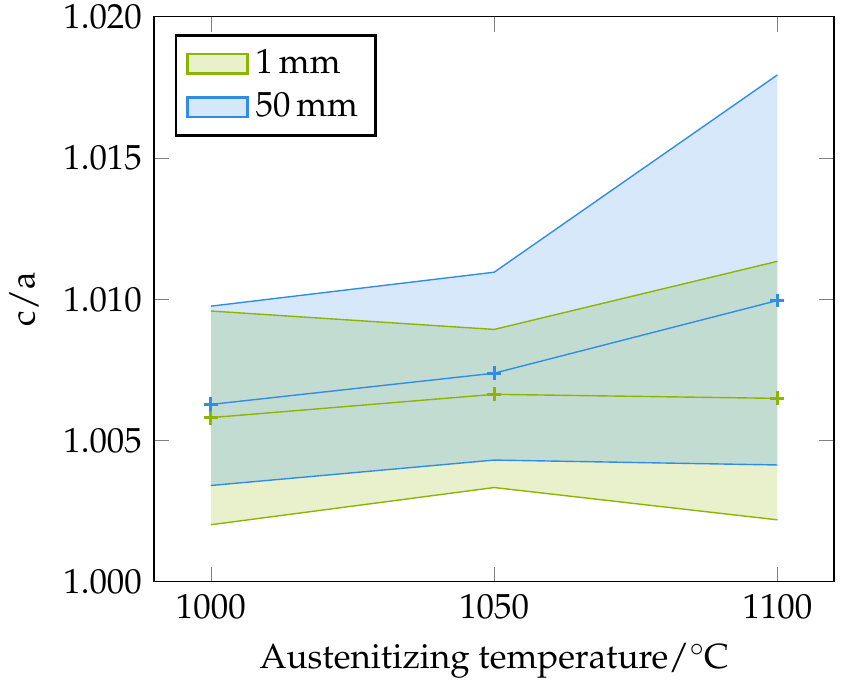
Figure 21. c/a ratio of martensite with respective scattering band (minimum and maximum) measured by XRD